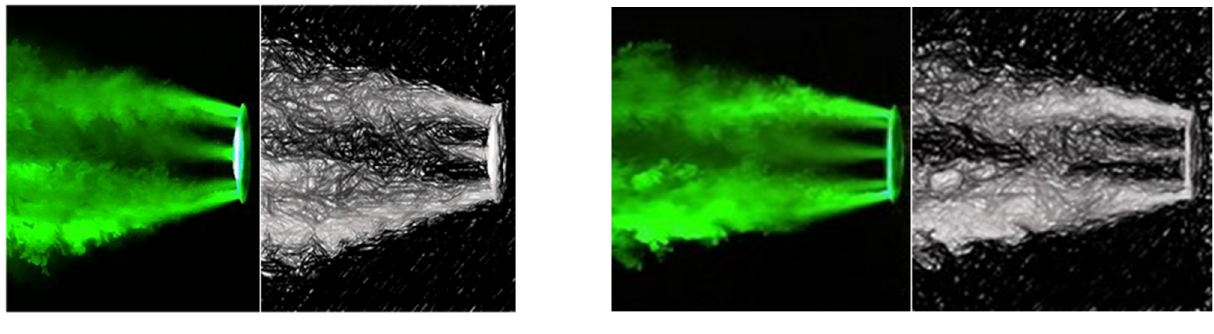
Figure 3. Visualization of the non-combustion field (Nozzle-mixed ( a ) Vs. Partially-premixed burner (b) (“b”_80mm)).